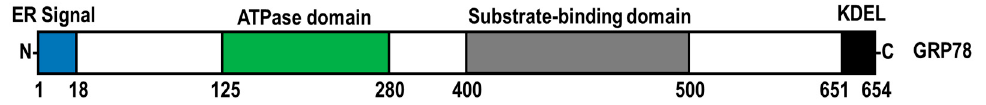
Figure 1. Functional domain structure of GRP78. GRP78 is composed of an ER signal sequence, ATPase domain, substrate-binding domain, and a C-terminal KDEL tetrapeptide sequence.